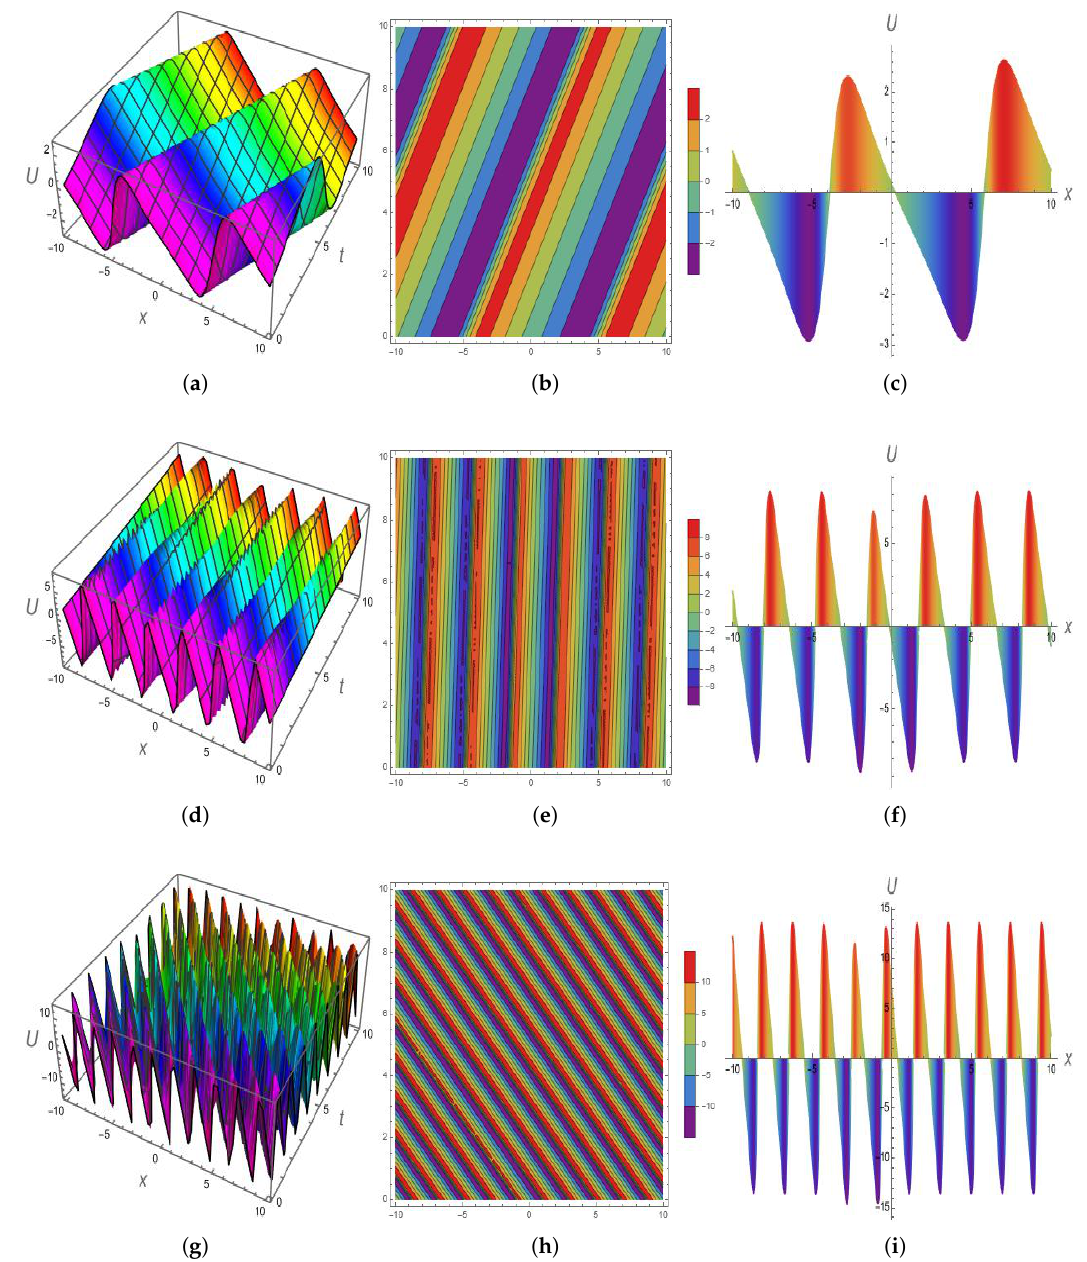
Figure 3. Three-dimensional, contour and 2-D profiles for the real part of solution £ 3 for different values of parameter k . ( a ) Three-dimensional propagation at k = 0.1; ( b ) Contour propagation at k = 0.1; ( c ) Two-dimensional propagation at k = 0.1; ( d ) Three-dimensional propagation at k = 0.3; ( e ) Contour propagation k = 0.3; ( f ) Two-dimensional propagation k = 0.3; ( g ) Three-dimensional propagation k = 0.5; ( h ) Contour propagation k = 0.5; ( i ) Two-dimensional propagation k =